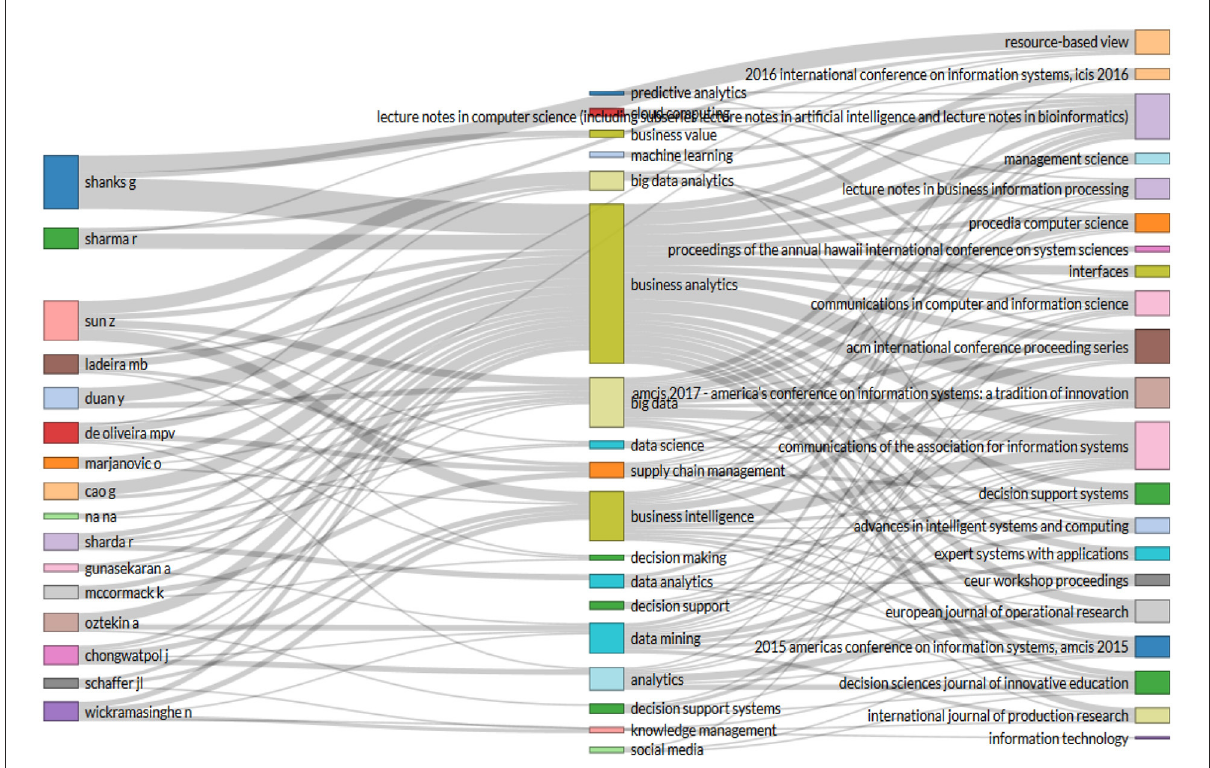
FIGURE6 Graph of three fields: Authors, subjects, and journal names. Source: Own elaboration using Bibliometrix.